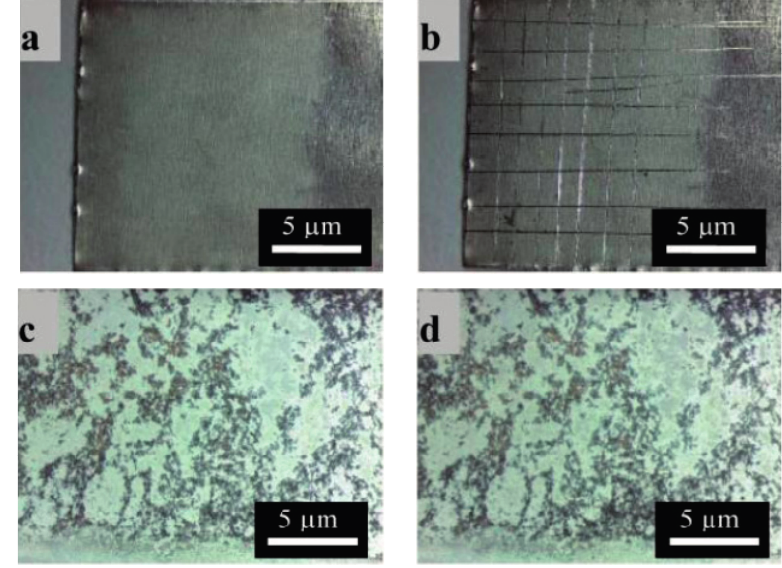
Figure 2. Optical microscopy images of chitosan micro BG coatings before ( a ) and after ( b ) Tape Test; and of chitosan nano BG coatings before ( c ) and after ( d ) Tape